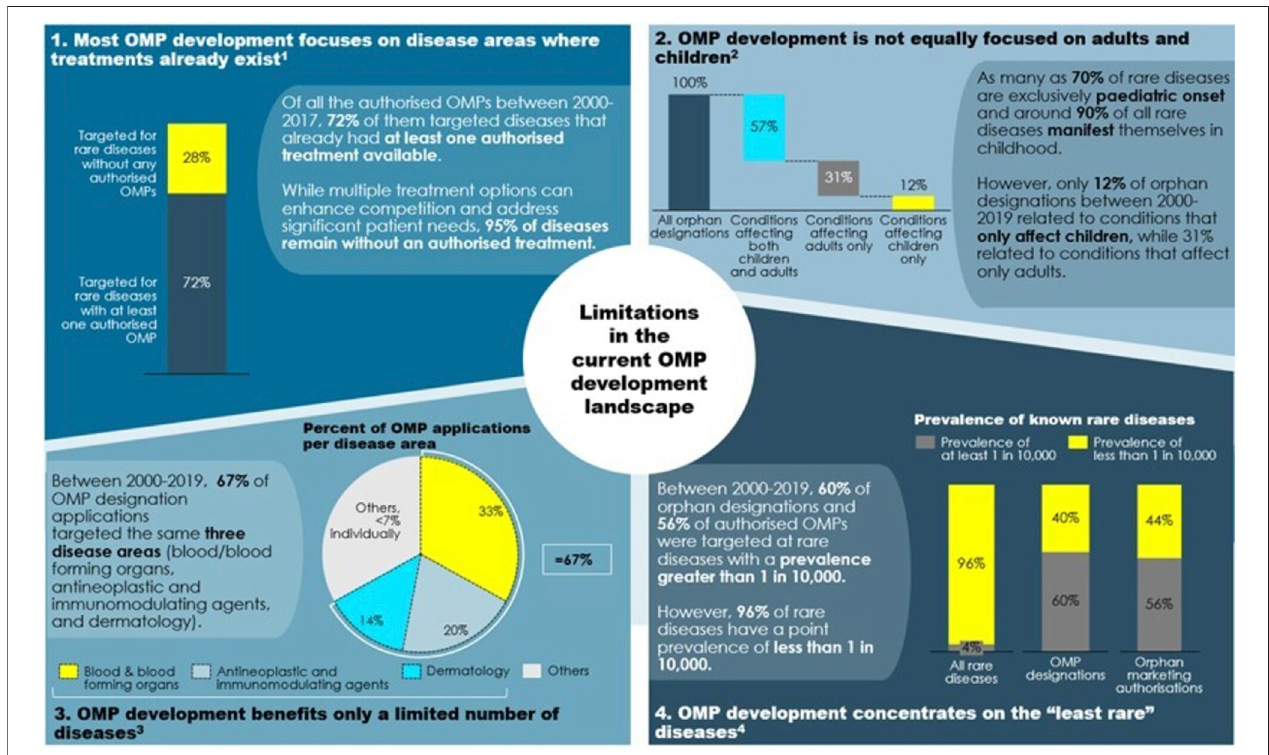
FIGURE 4 | Which areas are concerned by a lack of authorised treatments? Note: 1) Based on authorisations between 2000 and 2017. 2) Based on orphan